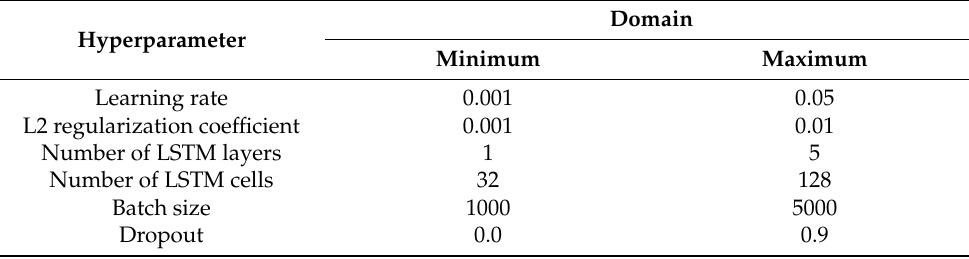
Table 2. Hyperparameter